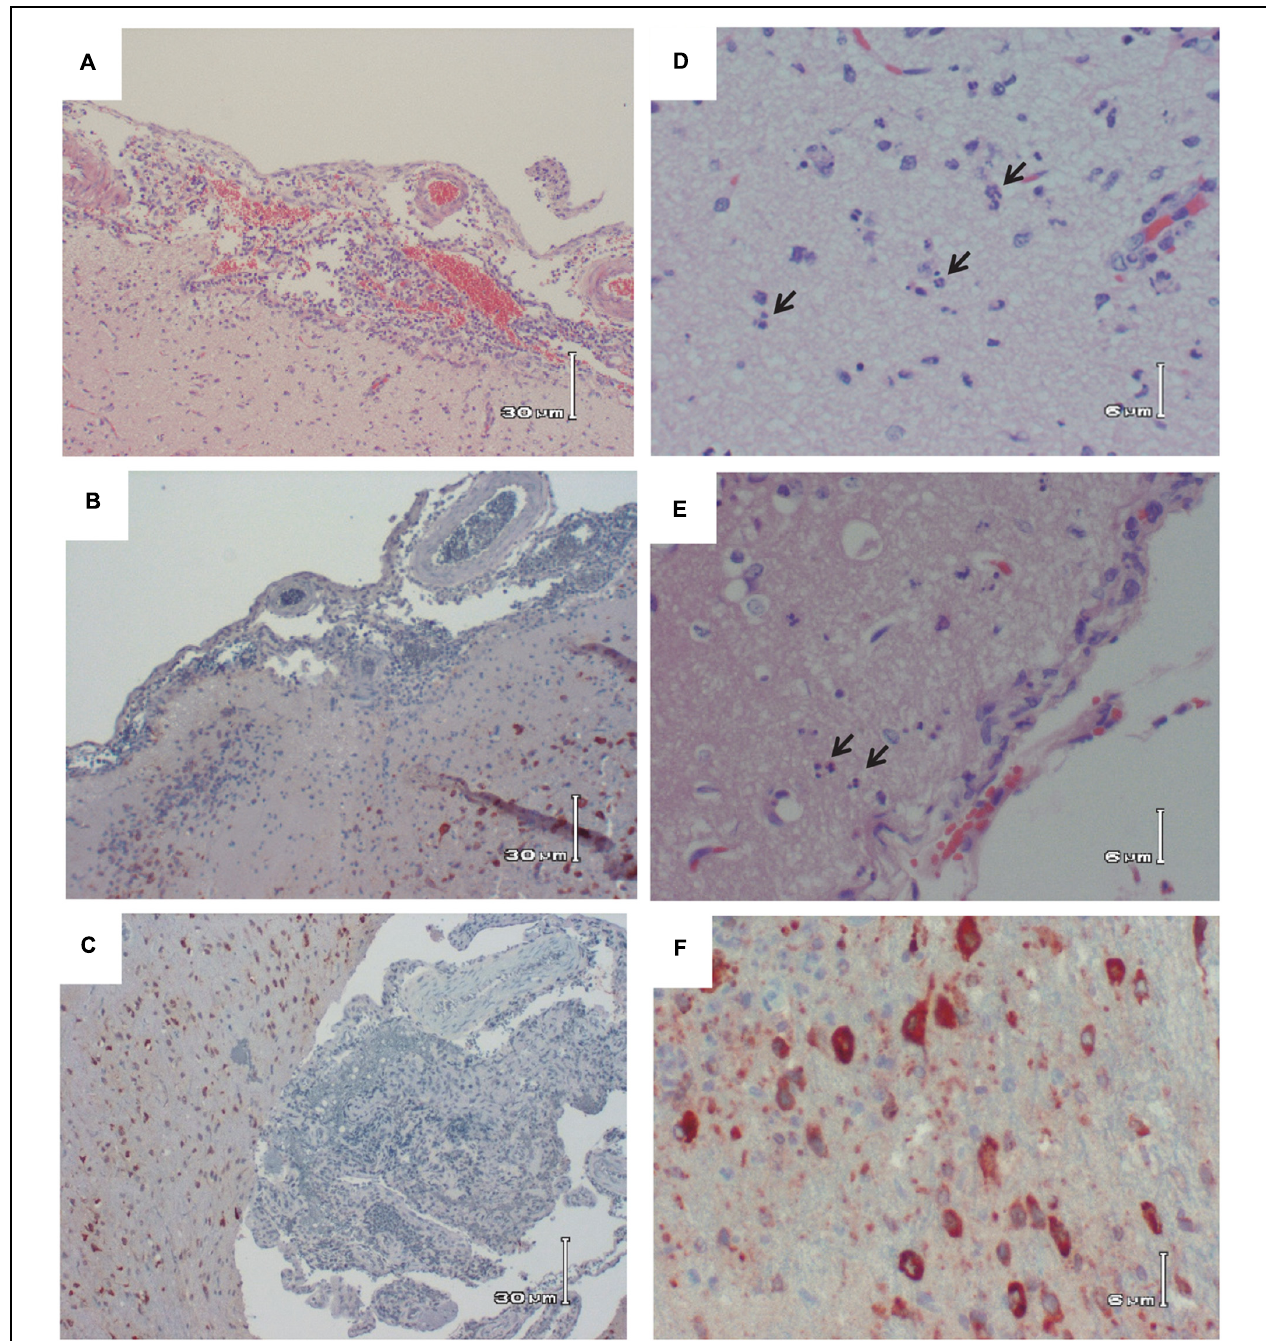
FIGURE 3 | Histologic images of the brain of RVFV-infected Lewis Rats. (A) H&E; Rat R819 taken 7 dpi; low magnification showing lymphocytic meningitis with apoptosis of the subcortical neurons. (B) IHC; Rat R819 taken 7 dpi; RVFV Ag + cells (reddish/brown staining) in the cortex with lymphocytic meningitis. (C) IHC; Rat R818 taken 7 dpi; low magnification illustrating the large number of RVFV Ag + cells in the cortex with marked lymphocytic meningitis. (D) H&E; Rat R819 taken 7 dpi; high magnification of subcortical cells with characteristic appearance of apoptosis (arrows). (E) H&E; Rat R821 taken 6 dpi; subcortical cells with characteristic appearance of apoptosis (arrows). (F) IHC; Rat R818 taken 7 dpi; high magnification of RVFV Ag + cells in cortex.